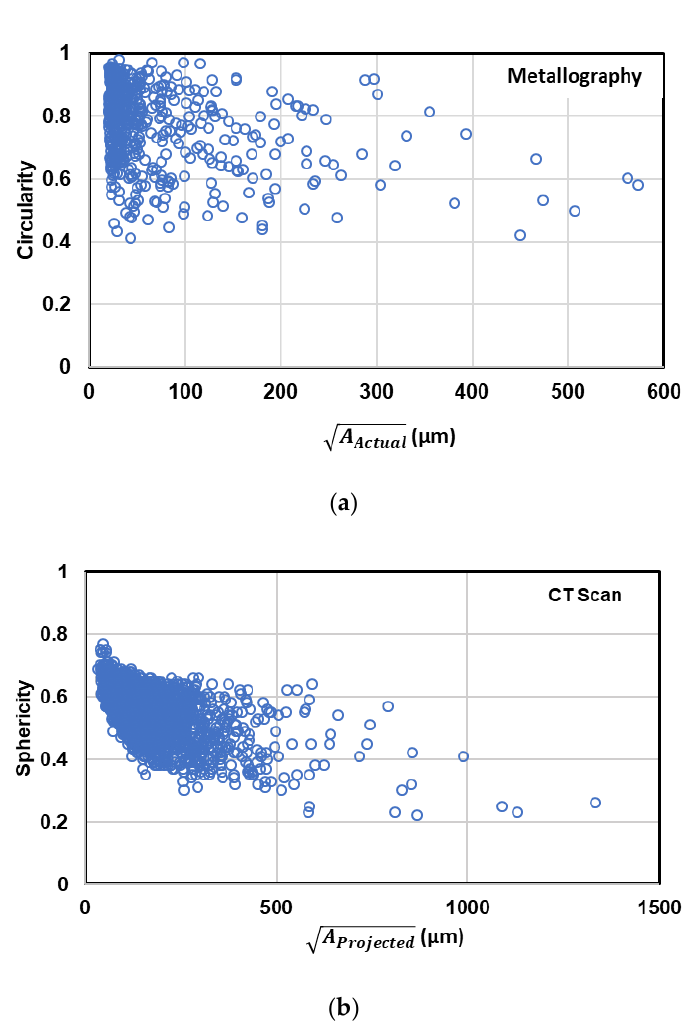
Figure 5. Comparison of the relation of defect size with sphericity or circularity of defect in ( a ) metallography and ( b ) µCT evaluations.